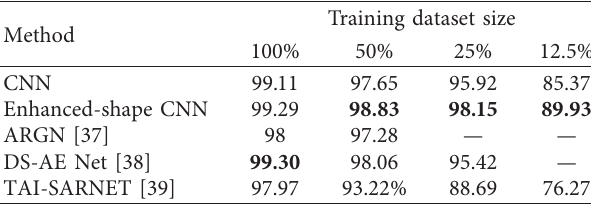
Table 5: Performances of different methods. Table 6: Recognition rate on different sizes of training